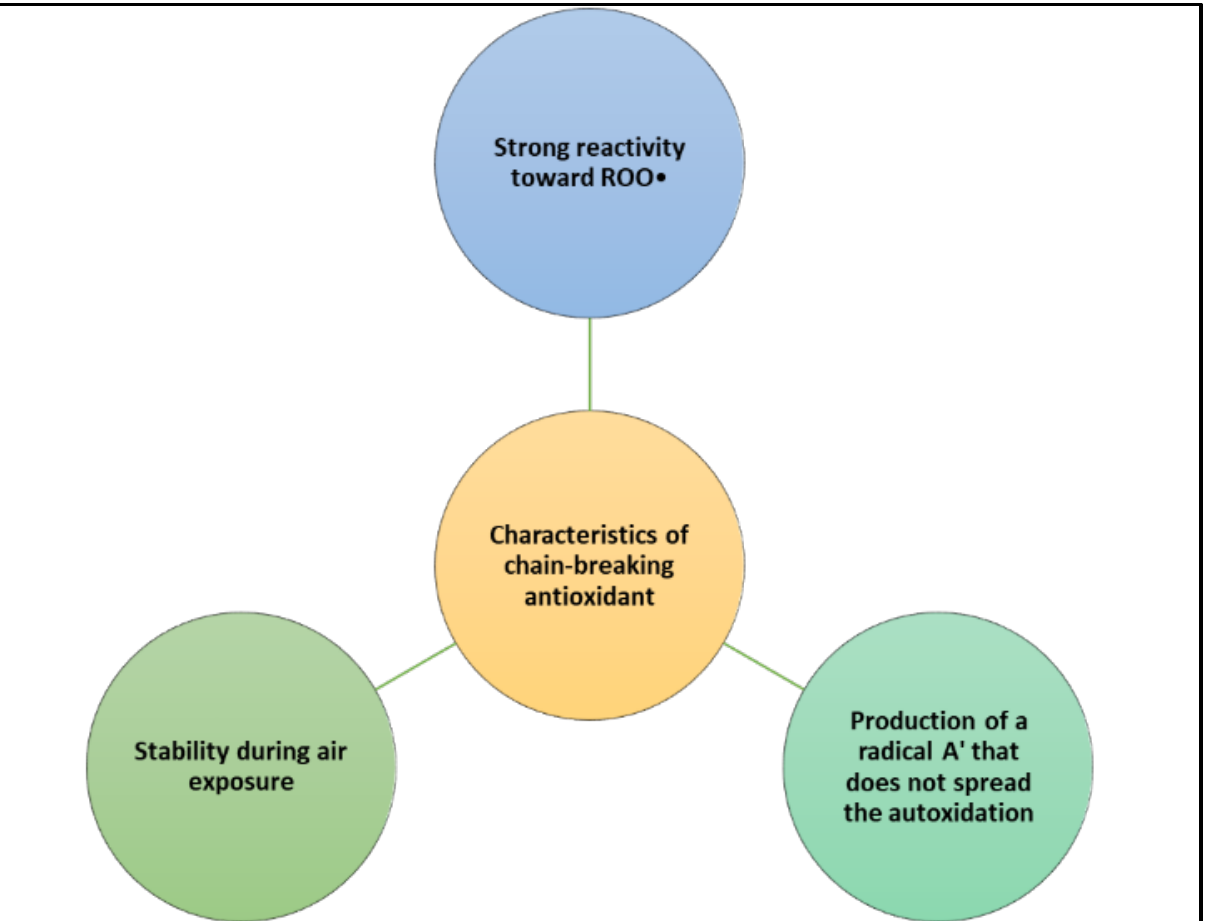
Figure 3. Characteristics of a chain-breaking antioxidant.